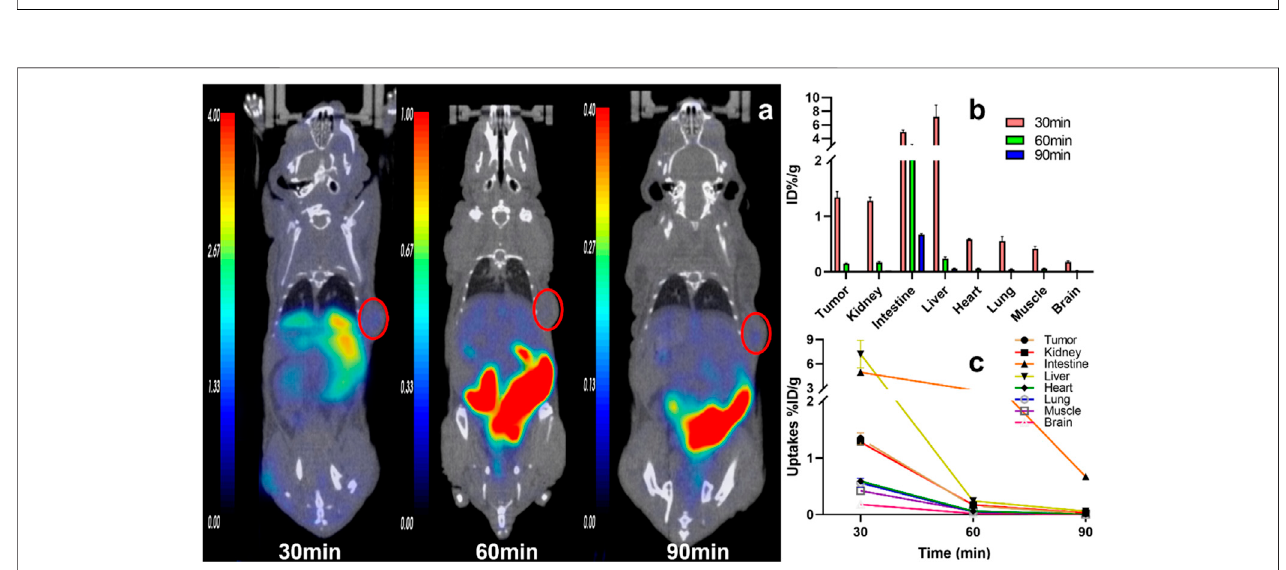
FIGURE 3 | The representative static PET imaging and distribution of 11 C-RJ1101, (A) the representative static PET imaging of 11 C-RJ1101 at 30, 60, 90 min in U87MG tumor-bearing nude mice.And the tumor wasindicatedby the red circle; (B) the organs or tissuesuptakesof 11 C-RJ1101in U87MG tumor-bearing nude mice at 30, 60, 90 min; (C) the time – active curve (TAC) of 11 C-RJ1101 at 30, 60, 90 min.